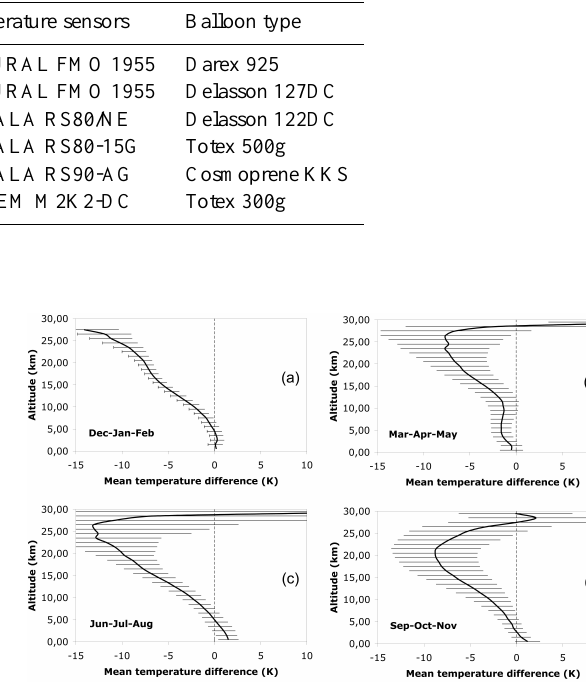
Fig. 1. Monthly averaged temperatures at 20km for every month (with color codes to distinguish between the seasons) between 1957 and 2008 as derived from daily radiosondes at Dumont d’Urville.